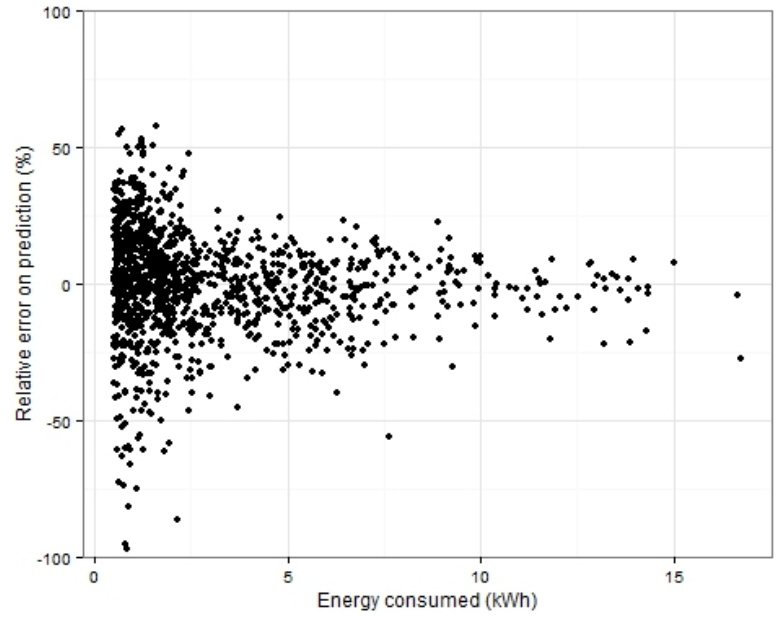
Figure 8. Relative error on the prediction (%) as a function of the consumed energy (kWh) in the trip for the hybrid